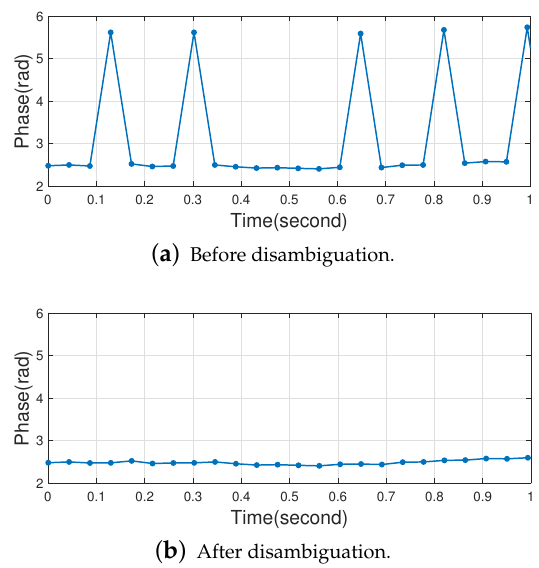
Figure 7. Phase data before and after radian disambiguation.